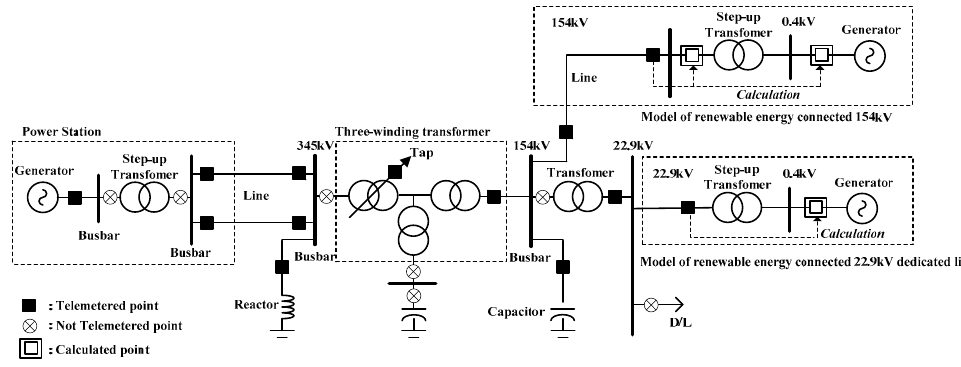
Figure 4. Locations of the analog points in KEPS.